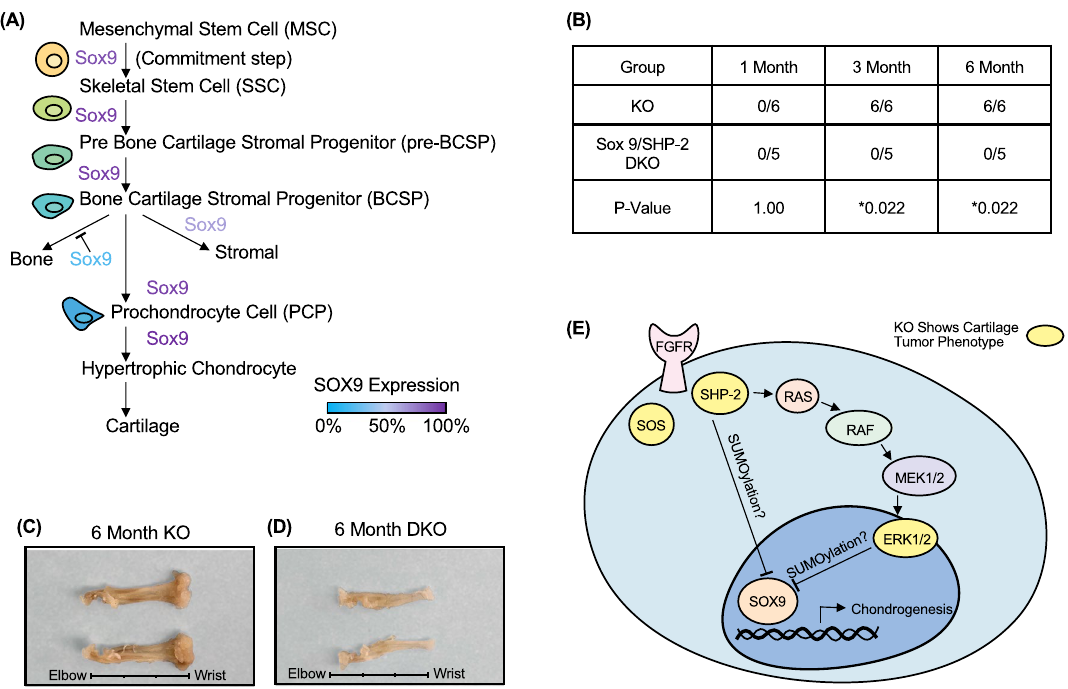
Figure 5. Chondrocyte tumor development is dependent on SOX-9. ( A ) Sox-9 expression in skeletal stem cell and chondrocyte development. ( B ) Gross observable wrist tumors from SHP-2 KO and SOX-9-SHP-2 KO animals at 1, 3, and 6 months of age. ( C ) SHP-2 KO and ( B ) SOX-9-SHP-2 KO representative images from adult 6-month-old forelimbs. ( D ) Graphical representation of chondrocyte SHP-2 SOX-9 relationship with a proposed role of fibroblast growth factor receptor